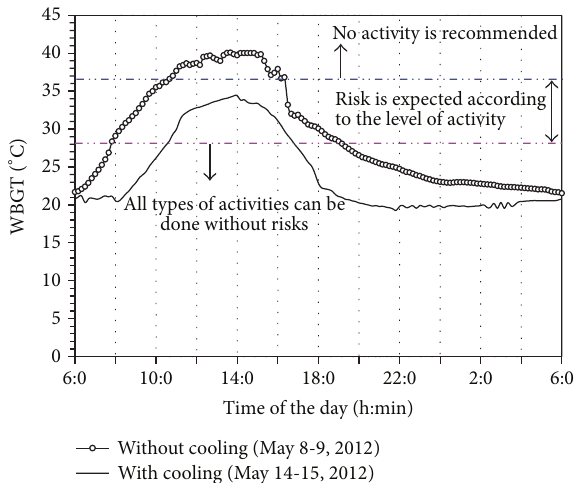
Figure 5: Time course of the physiological effective temperature (PET) estimated in the greenhouse with and without cooling of the inside